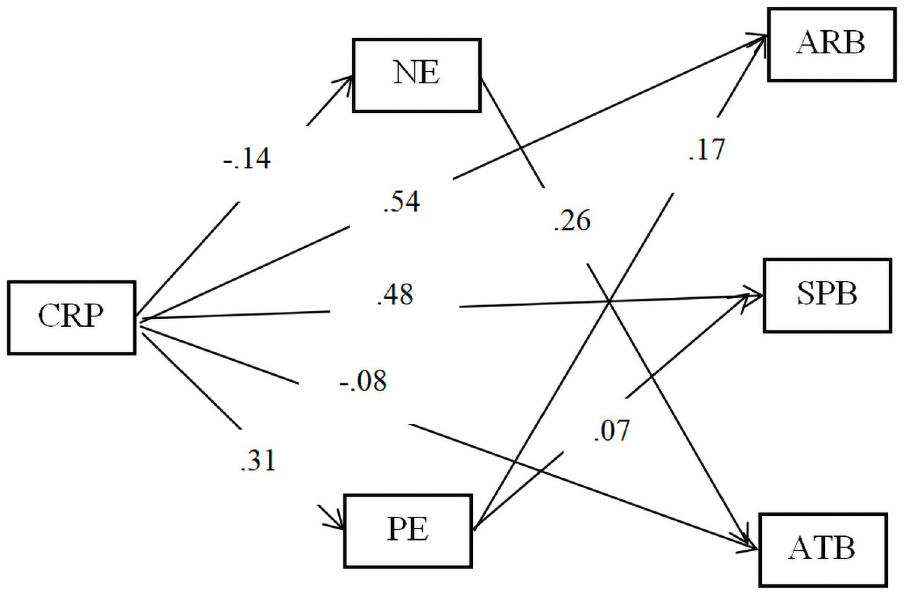
Fig 2. The mediating effect of PE and NE on the relationship between CRP and CRC. SPB = Self-protection behaviour, PE = positive emotion, NE = negative emotion, ARB = Active-response behaviour, SPB = Self-protection behaviour, CRP = COVID-19-related risk perception, RTB = Risk-taking behaviour. X = CRP, W1 = NE, W2 = PE, Y1 = ARB, Y2 = SPB, Y3 = RTB. Non-significant coefficients were not presented. Demographic variables controlled; n =